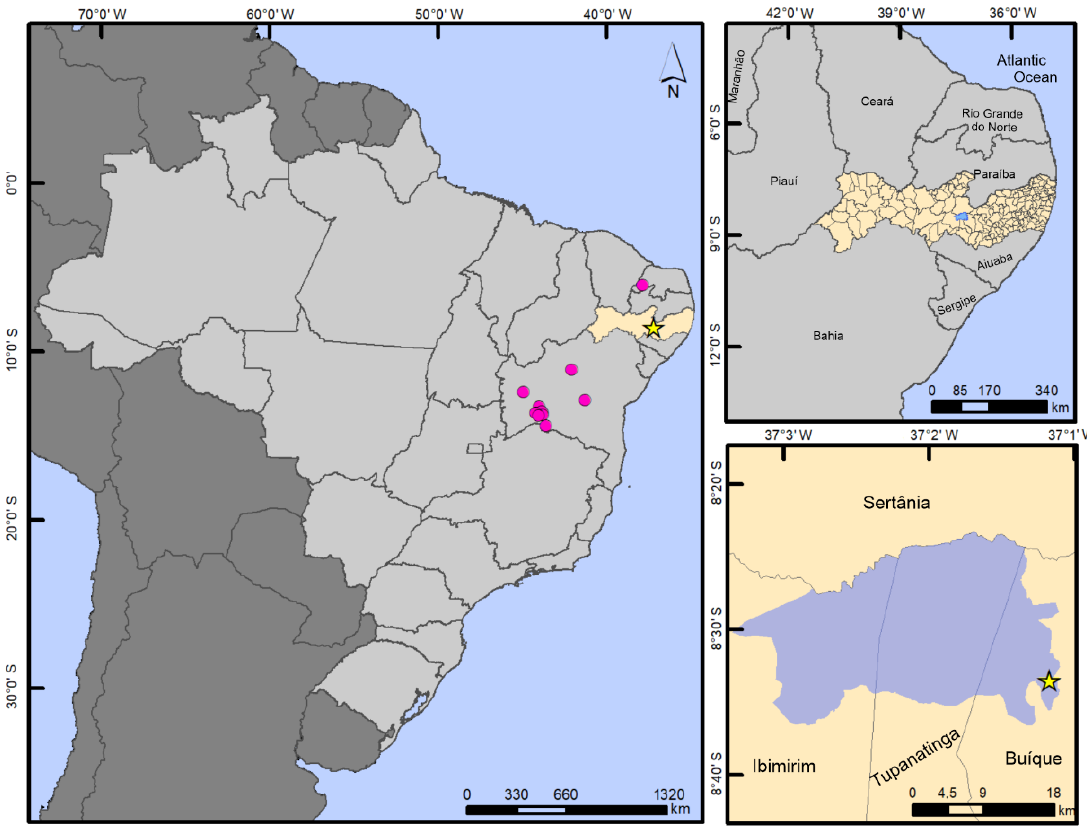
Figure 9. Geographic distribution of P. digitata . Pink circles show the previous records in Rio Grande do Norte and Bahia states. Yellow star shows the new record from Catimbau National Park (highlighted in blue), Pernambuco state (highlighted in beige).